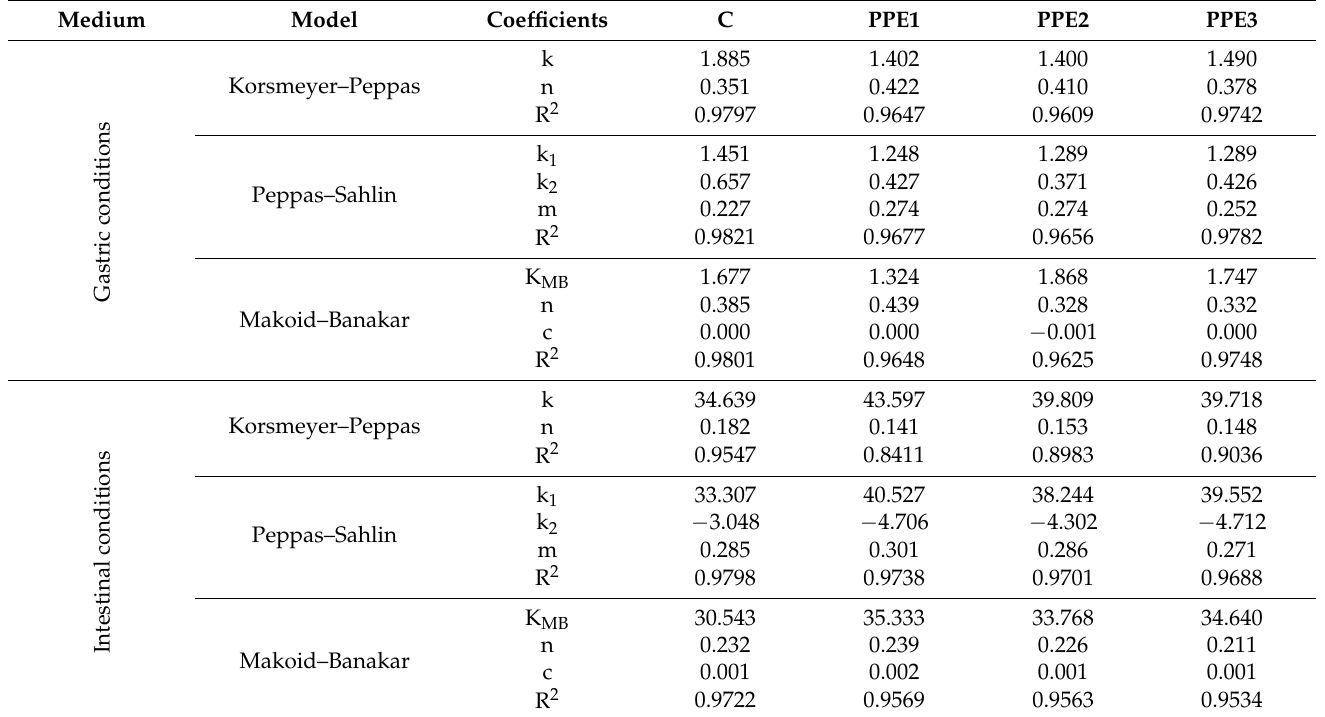
Table 3. The release model parameters of total phenolic compounds from “Boba balls” hydrogel to the stomach and intestinal